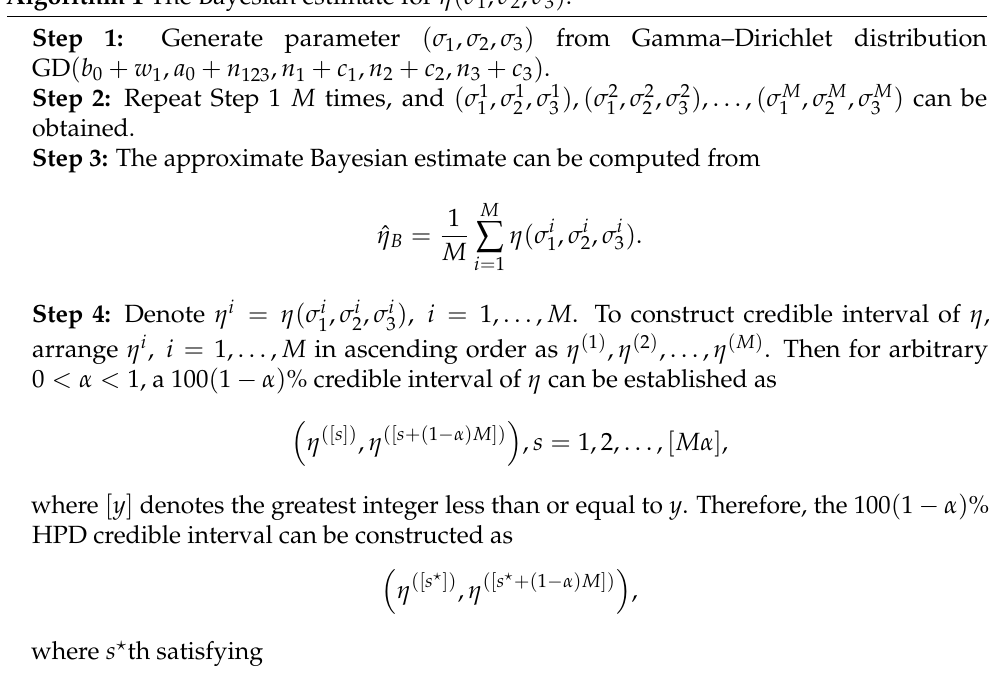
Algorithm 1 The Bayesian estimate for η ( σ 1 , σ 2 , σ 3 )